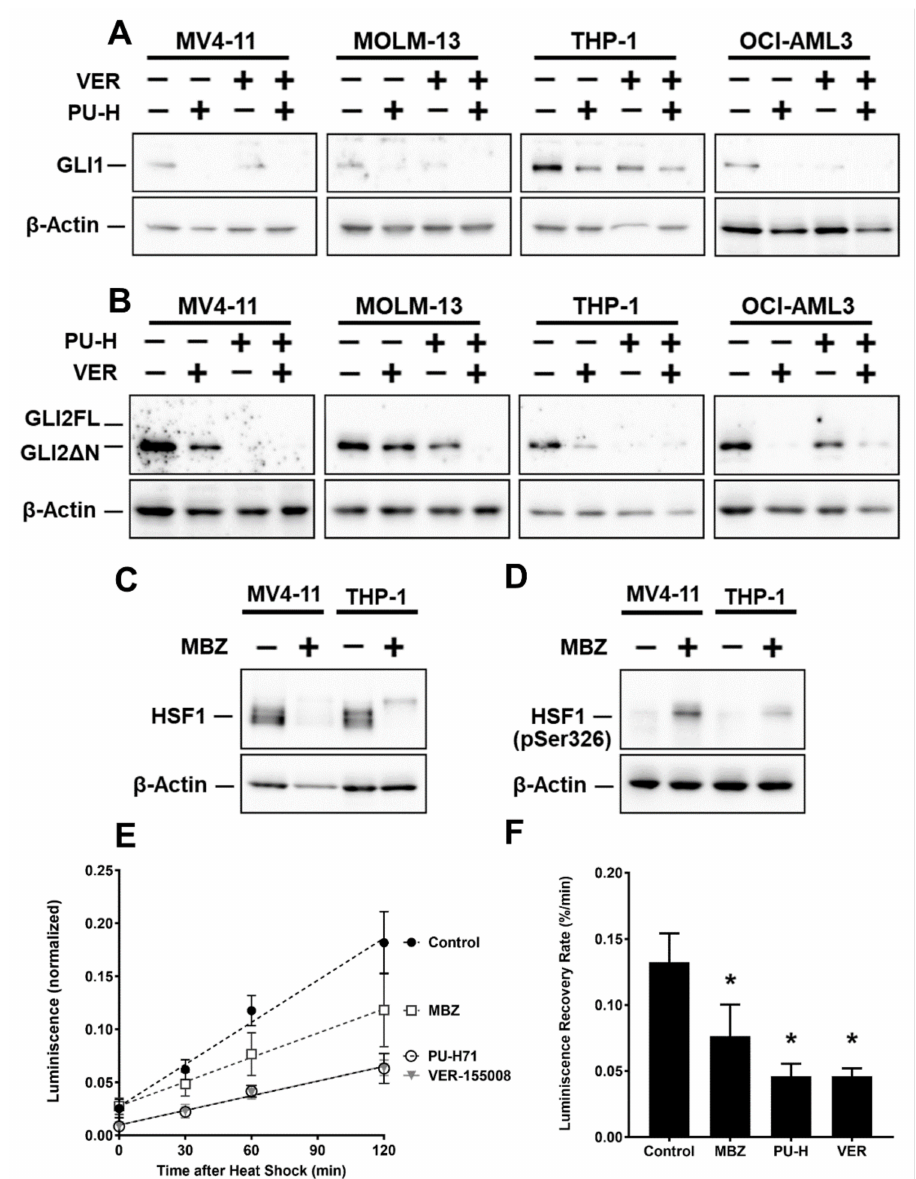
Figure 3. MBZ promotes degradation of GLI Transcription Factors via Inhibition of HSP70/90- Chaperone Activity. AML cell lines MV4-11, MOLM-13, THP-1 and OCI-AML3 have been treated with 1 µ M PU-H71 (PU-H) and 25 µ M VER-155008 (VER) for 24 h. Subsequently expression of GLI1 ( A ) and GLI2 ( B ) was examined by western blot analysis. ( C , D ) AML cell lines MV4-11 and THP-1 were treated with 500 nM MBZ or DMSO as a solvent control for 24 h and protein levels of HSF-1 and phosphorylated HSF-1 (Ser-326) were determined by western blot analysis. Phosphorylated HSF-1 (Ser-326) represents the active state of HSF-1. ( E ) MOLM-13 luc+ cell line constitutively expressing a firefly luciferase were incubated with 10 µ M MBZ, 1 µ M PU-H71 (PU-H), 25 µ M VER-155008 (VER) or a solvent control. Following a heat-shock, recovery of the intracellular luciferase activity was measured on different time points and normalized to the luciferase activity of the non-heat-shock native control. ( F ) The luminescence recovery rate derived from ( E ) as the slope of the luminescence increases after treatment with MBZ, PU-H71 (PU-H), VER-155008 (VER) or a solvent control. Error bars represent the mean values ± standard deviation from at least three independent experiments. * p < 0.05 in the Welch’s t